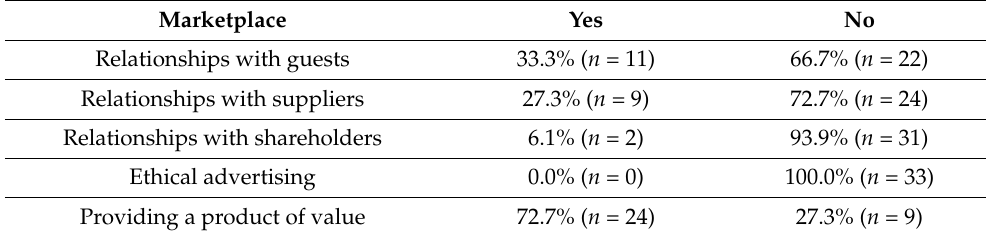
Table 7. Aspects of CSR activities: Marketplace.